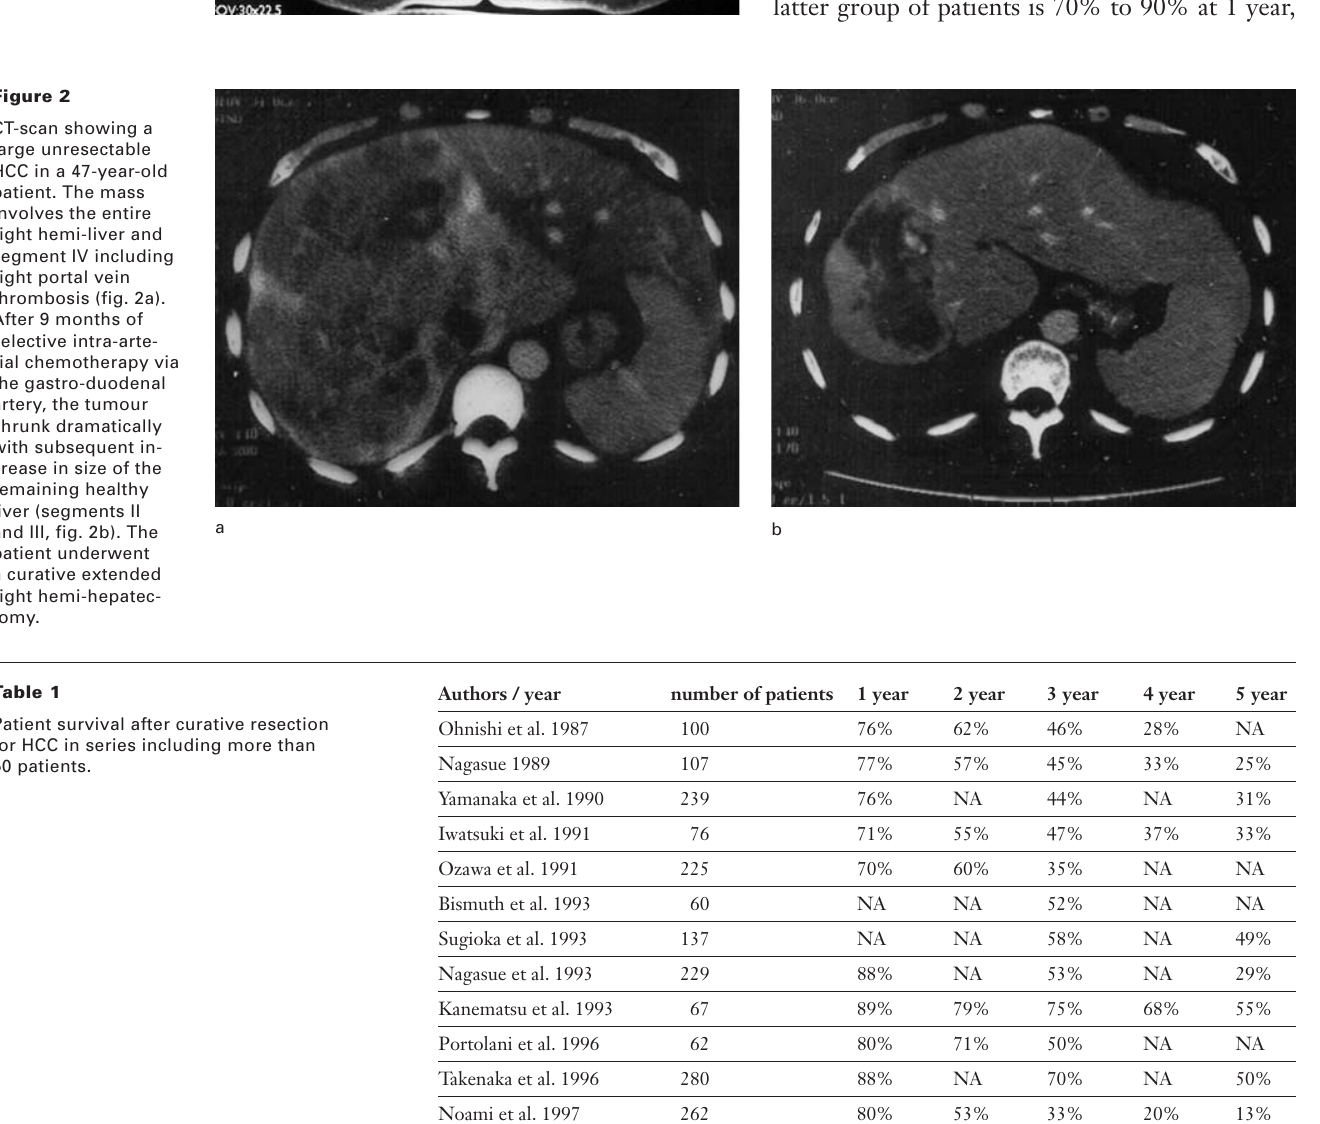
CT-scan showing a large hepatoma with- out underlying liver disease in a 54-year- old patient. The mass involves segment IV, V and VIII of the liver. The patient under- went a successful curative central re- section of the liver using a technique of total vascular exclusion. To date there has been a disease free survival of 18 months.